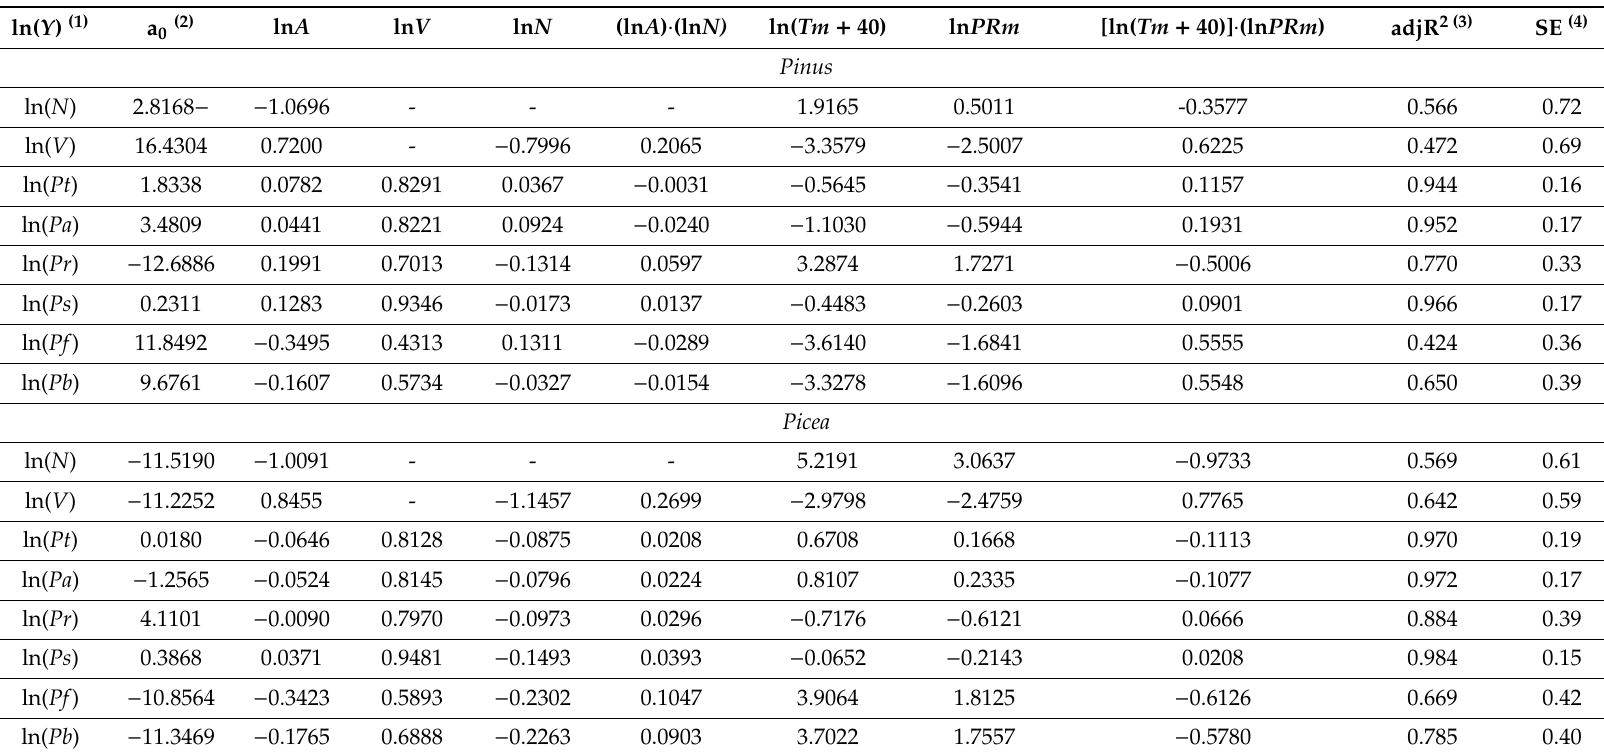
Table 1. Characteristic of Equation (1) for forest stands of the subgenus Pinus spp., and the genus Picea spp. in